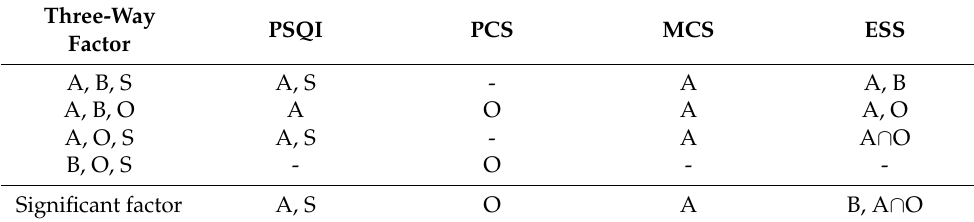
Table 2. The crossing matrix for self-reported HRQoL in the three-way ANOVA